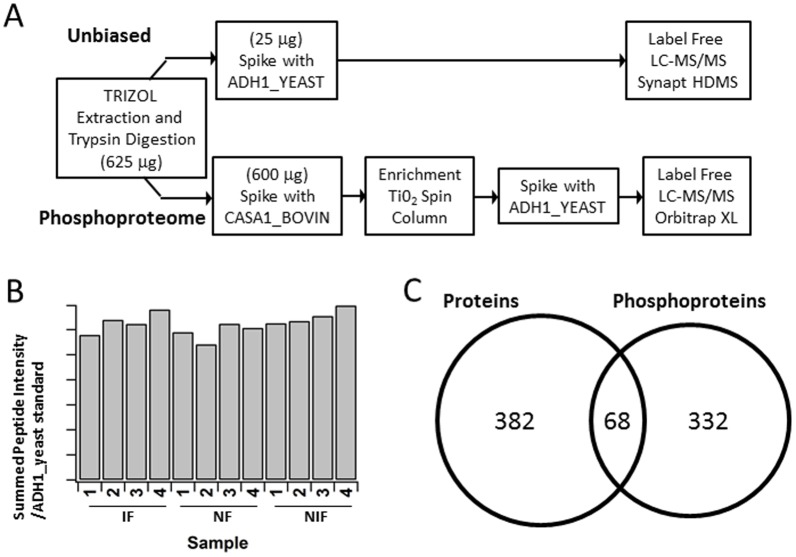
Experimental Approach.A: Illustration of the sample preparation and MS work flow. B: Reproducibility/Internal Control. Relative levels of the ADH1 protein spiked into each heart lysate as determined by chromatographic peak intensity. C: Venn Diagram demonstrating the protein and phosphoprotein yield and overlap.